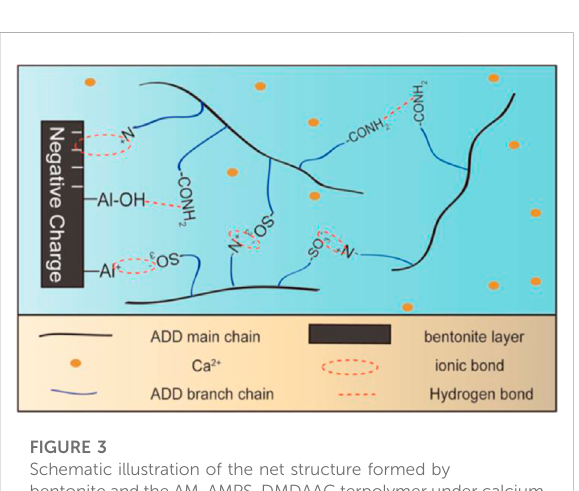
FIGURE 3 Schematic illustration of the net structure formed